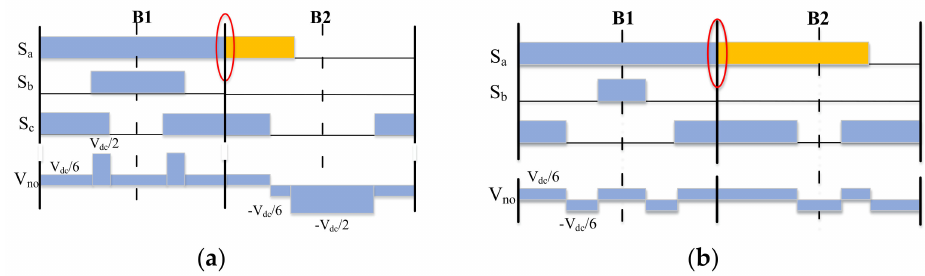
Figure 6. Solution for discontinuous switching in TSPWM: ( a ) low region; ( b ) high